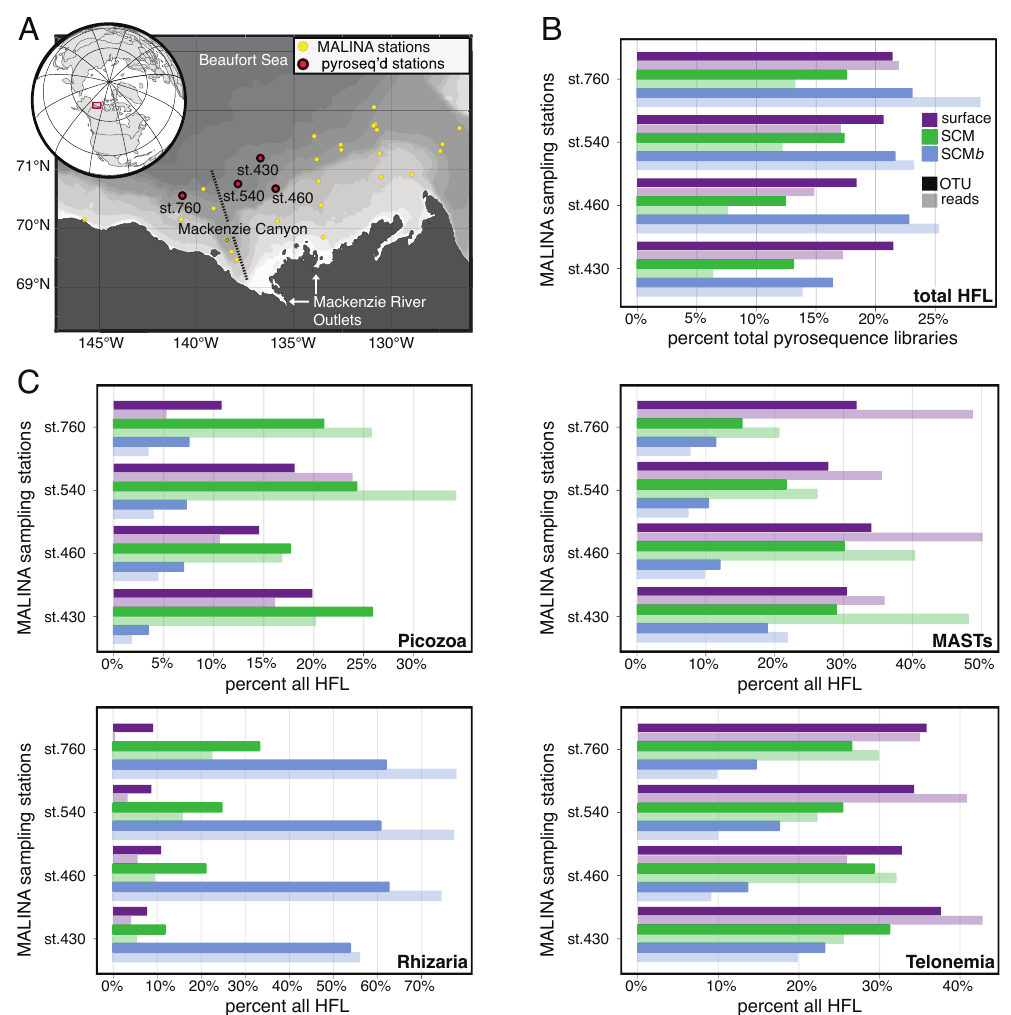
Fig. 1. (A) Beaufort Sea stations sampled during leg 2B of the Malina cruise (August 2009). (B) Overall distributions of HFL reads and OTUs (clustered at ≥ 98% sequence identity) of sequenced Beaufort Sea microbial eukaryotic communities. Purple, green and blue bars represent surface, SCM and SCM b depths, respectively. Solid and transparent color bars represent OTU and read distributions, respectively. (C) OTU and read distributions of main HFL taxonomic groups across Beaufort Sea